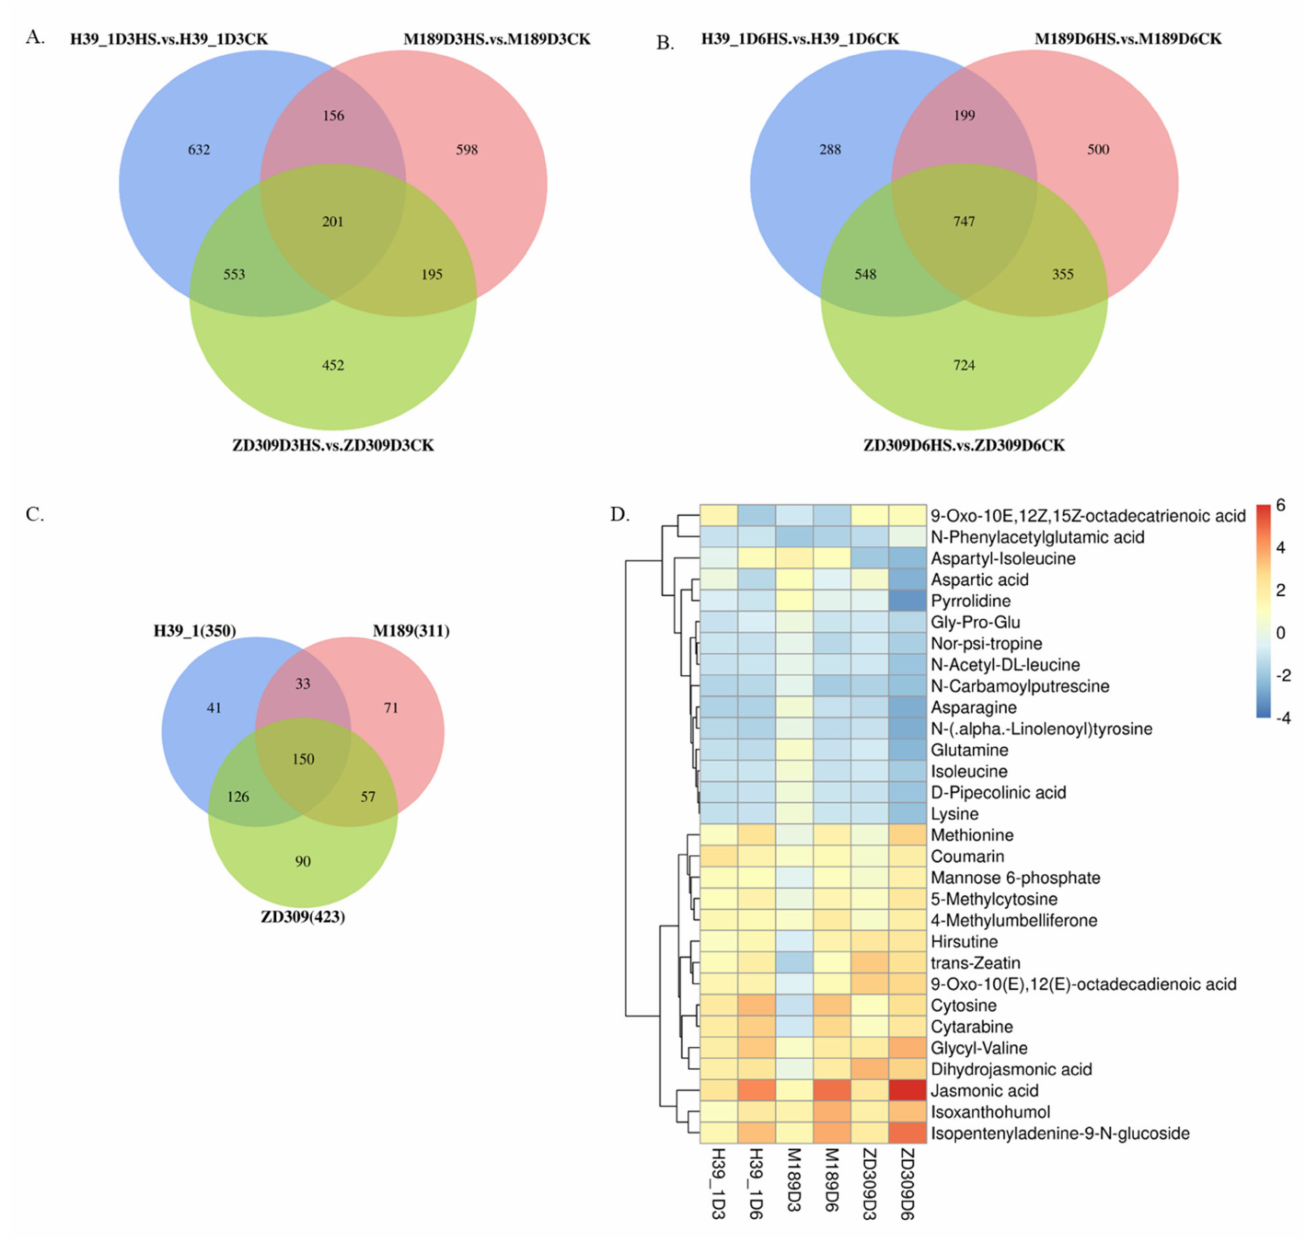
Figure 7. DEMs and expression pattern identifications within ZD309 and its parental lines. ( A ) DEMs numbers of ZD309 and its parental lines in D3HS treatment; ( B ) DEMs numbers of ZD309 and its parental lines in D6HS treatment. ( C ) Conserved DEGs numbers of ZD309 and its parental lines between D3HS and D6HS. ( D ) Expression patterns of the conserved DEMs between the two heat